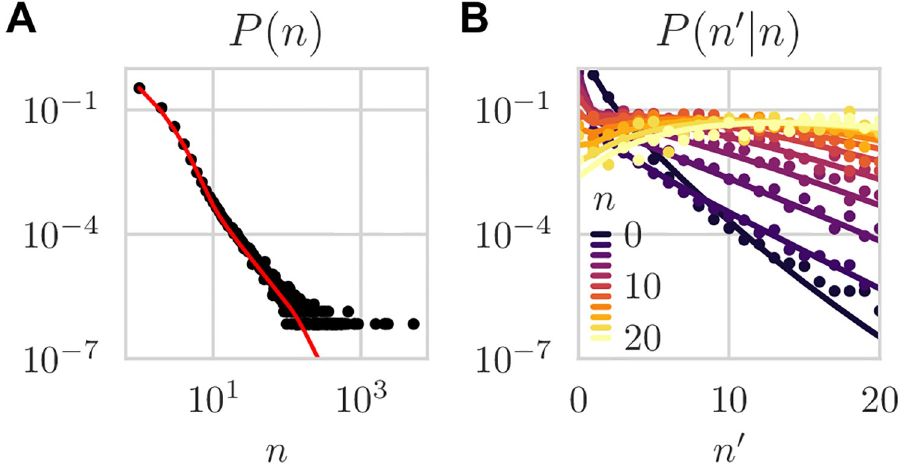
Fig 3. Count distributions. (A) Marginal count distribution, P ( n | θ null ) = ∑ n 0 P ( n , n 0 | θ null ), and (B) conditional count distribution, P ( n | n 0 , θ null ) = P ( n , n 0 | θ null )/ P ( n | θ null ). Both marginal and conditional distributions are quantitatively predicted by the model. Lines are analytic predictions of the learned model. Dots are estimated frequencies. (Same data as Fig 2 two-step noise model).